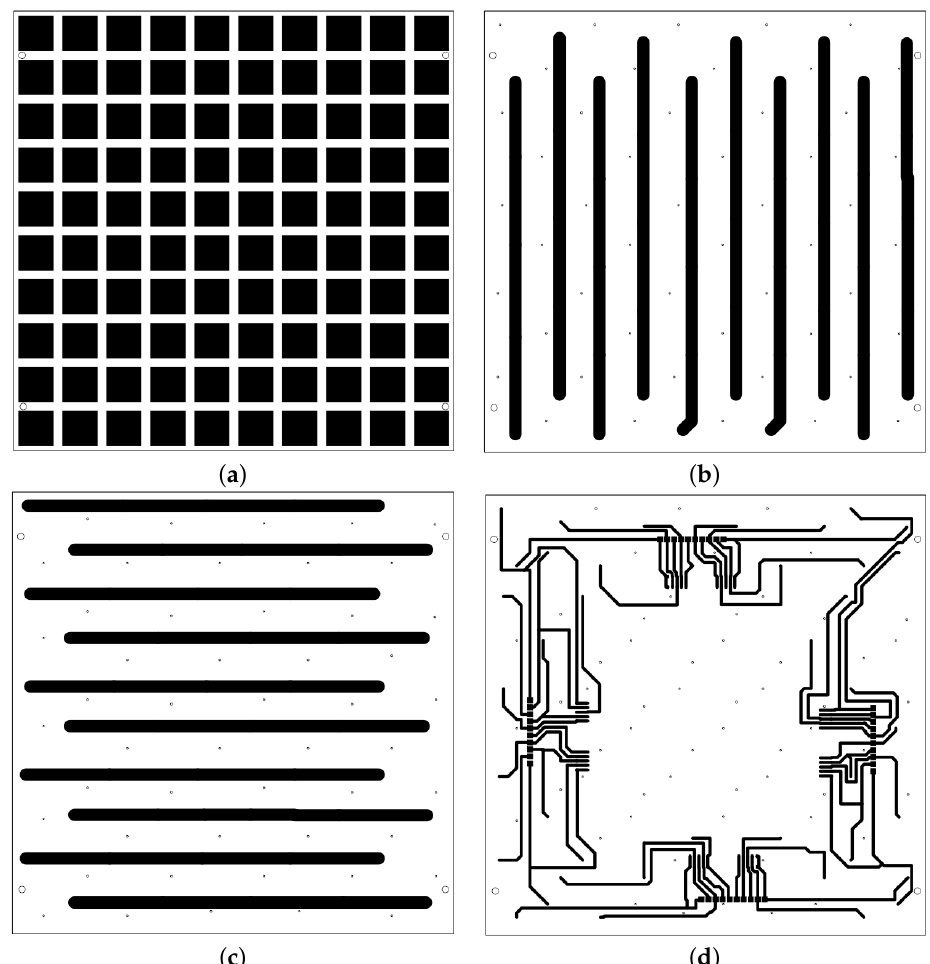
Figure 10. In this figure, the conductive layers of the PCB of a tile are shown: ( a ) Top layer, with the gold coated square contacts, ( b ) Mid layer 1, for the distribution of the power supply to the contacts for which the sum of l and m (see Section 2.1) is an even number, ( c ) Mid layer 2, for the distribution of the power supply to the contacts for which the sum of l and m is an odd number, ( d ) Bottom layer, with the connections between the PCB back side connectors (see Section